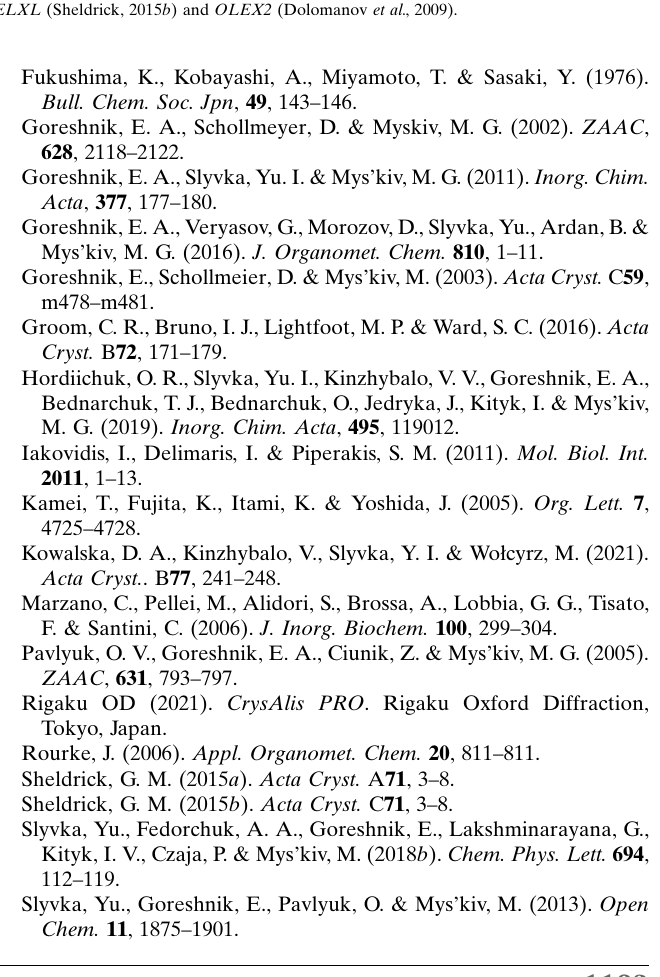
Table 5 Experimental details. Crystal data Chemical